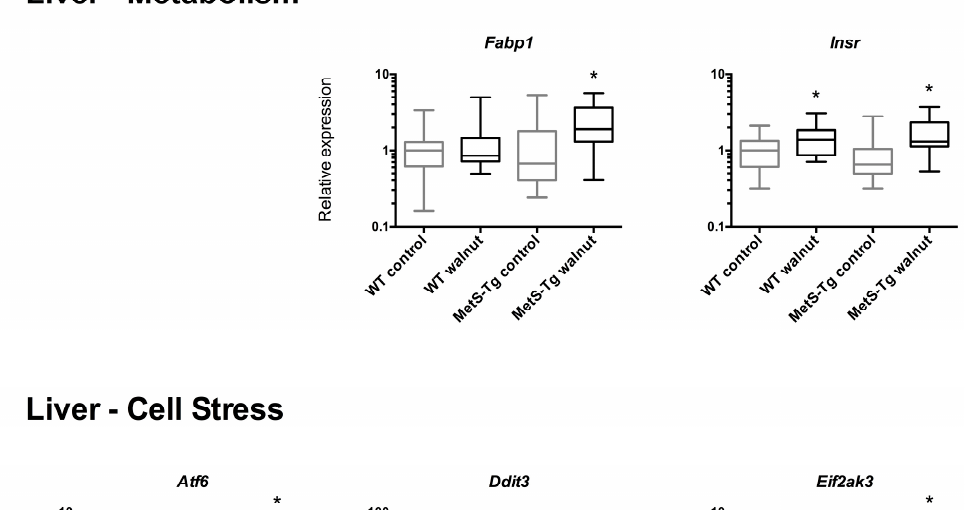
Figure 2. ( A ): Relative levels of gene expression in liver for genes associated with fibrosis ( Hgf , Sp1 , Timp1 ), as medians (Interquartile Ranges) with WT control expression set to 1, * p < 0.05, ** p < 0.005. ( B ): Representative sections of liver tissue stained with Masson Trichrome, indicating a gradient of interstitial fibrosis (blue), lowest in WT Control diet, and highest in MetS-Tg Walnut diet (10× magnification).